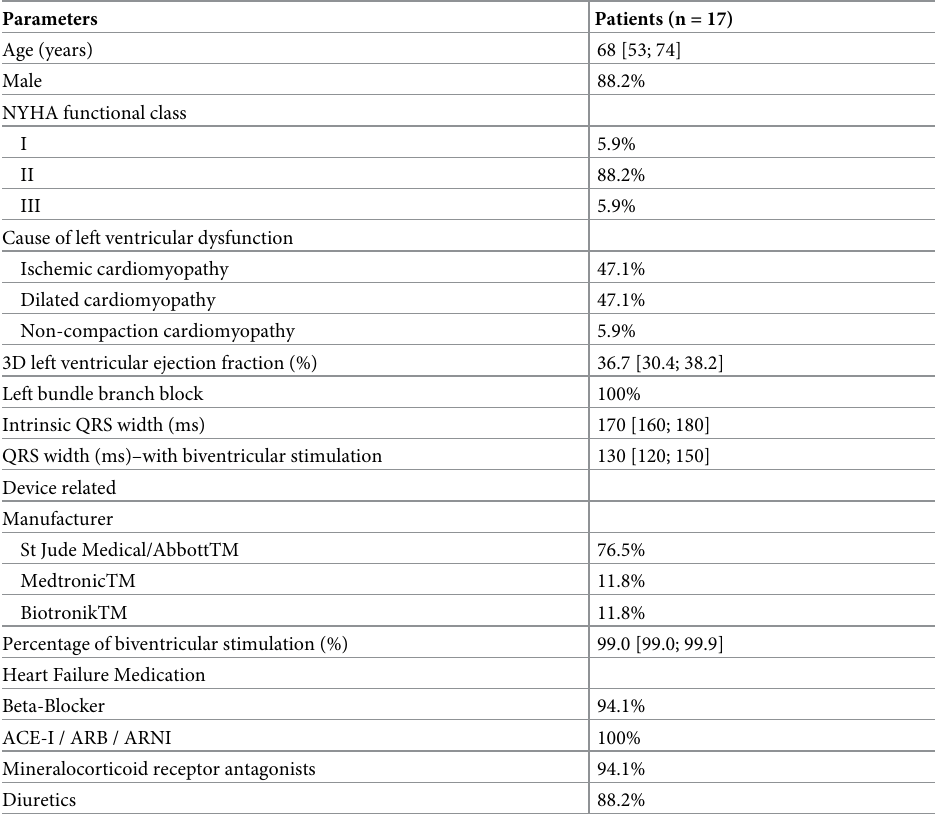
Table 1. Patient characteristics (n =